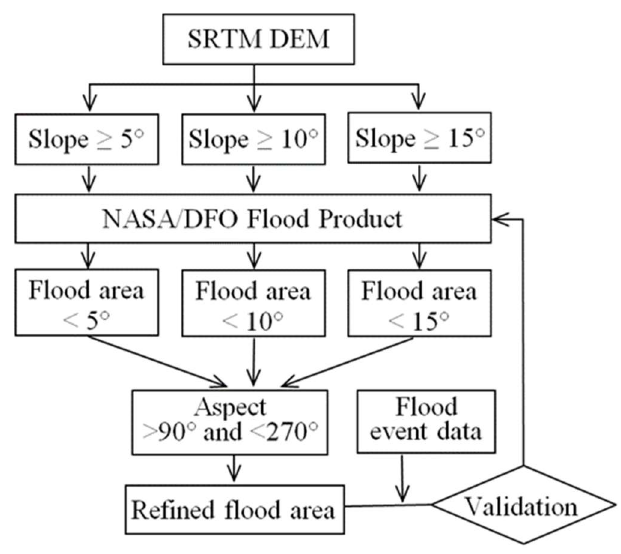
Figure 3. Flowchart of the proposed method. Fremont County was selected to represent the mountain region (Figure 2), and it experienced the Colorado flood in September 2013. As this county is surrounded by a few mountains and peaks, certainly these valleys become a potentially higher risk for flood misclassification (Figure 4). Figure 3 shows the effects of the algorithm used to filter the misclassified area at 5 ◦ and 10 ◦ . In order to test this algorithm in a flat area, we selected one county at Midwest Iowa County, Iowa, during the flooding period between May and June 2013. We also conducted the same step for southeastern Idaho to represent combined mountainous and flatland